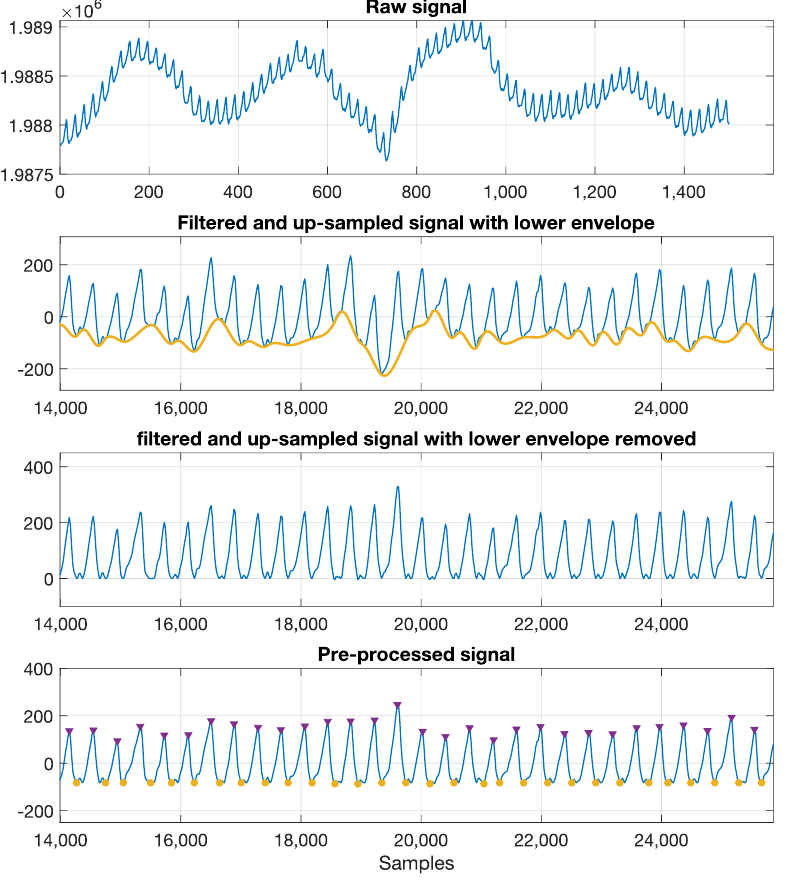
Figure 4. Pre − processing steps for the raw PPG. Top to bottom: raw signal; band − pass signal with the lower envelope detected; upsampled signal with the lower envelope removed; pre − processed signal with the peaks and troughs